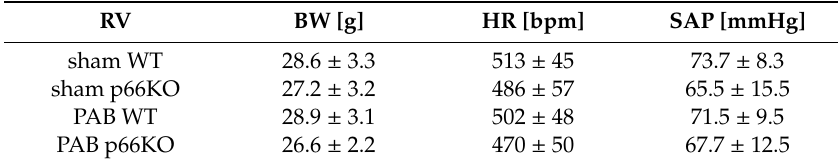
Table 2. Body weight (BW) and hemodynamic values in mice three weeks after pulmonary artery banding (PAB) or sham surgery. Data show the BW (in g), heart rate (HR in bpm) and systemic arterial pressure (SAP in mmHg) of wild type (WT) and p66shc knockout (p66KO) mice three weeks after sham surgery or PAB. Data are shown as means ± SD. Data for BW and HR were pooled from the animals of all study groups (WT sham: n = 16, WT PAB: n = 15, p66KO sham: n = 15 and p66KO PAB: n = 18, respectively). Data for SAP were obtained from the animals included in hemodynamic analysis (WT sham: n = 6, WT PAB: n = 7, p66KO sham: n = 6 and p66KO PAB: n = 9, respectively). Data were compared by two-way ANOVA.